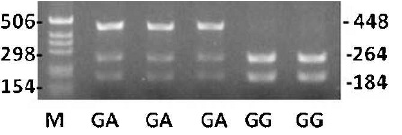
Figure 1- Agarose gel (2%) electrophoresis of Hha I-digested PCR products; M, 1kb DNA ladder (Invitrogen, USA) was used as marker of DNA fragment sizes; GA, bands of 448 bp, 264 bp, and 184 bp connote the GA genotype of three individuals; GG, two bands of 264 bp and 184bp connote the GG genotype of the other